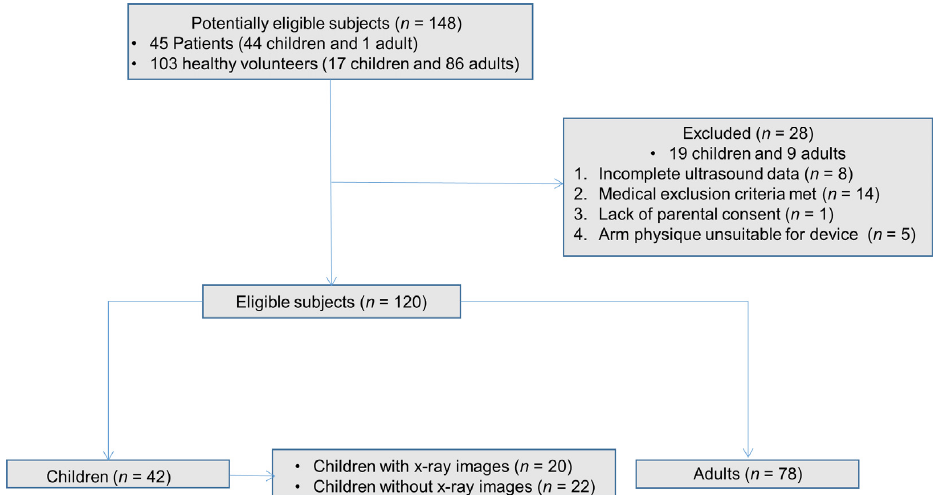
Figure 6. STARD 2015 flowchart of the study cohort. Exclusion criteria were previous fracture of the left wrist, hand, or underarm; precocious puberty; pubertas tarda; growth hormone deficiency; congenital adrenal hyperplasia; previous radio- or chemotherapy; previous high-dose steroid therapy; Turner syndrome; Down syndrome; transgender individuals undergoing/previous hormone therapy; tall stature individuals undergoing hormone therapy; non-treated hyper- or hypothyroidism or severe obesity (BMI > 40).